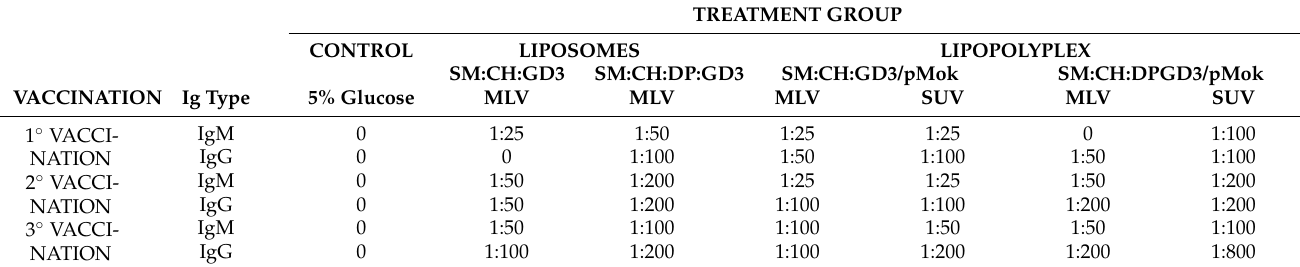
Table 3. Serological responses to immunization with GD3 antigen after the first, second, or third dose of vaccine. Animals were immunized with liposomes bearing the GD3 antigen (SM: CH: GD3 or SM: CH: DP: GD3) or with lipopolyplexes bearing GD3 and the pMOK plasmid bearing GM-CSF cytokine gene. Titers of anti-GD3 immunoglobulins were determined by ELISA. The titers correspond with the maximal dilution of mice serum that yielded an optical density above 0.100. These determinations were performed in triplicate and only results with dispersion lower than 5% were accepted.